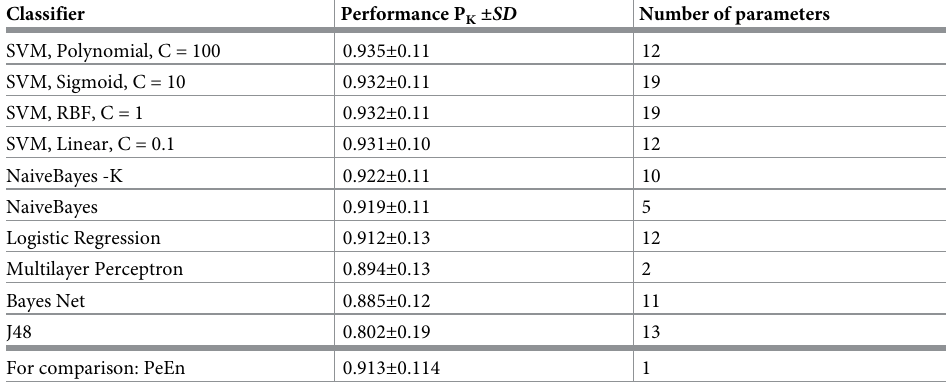
Table 1. Highest prediction performances of the different classifiers using plain information-based feature selec- tion, along with the number of parameters used in the best prediction run. For comparison, the performance of the single parameter with the highest PK value, permutation entropy, is